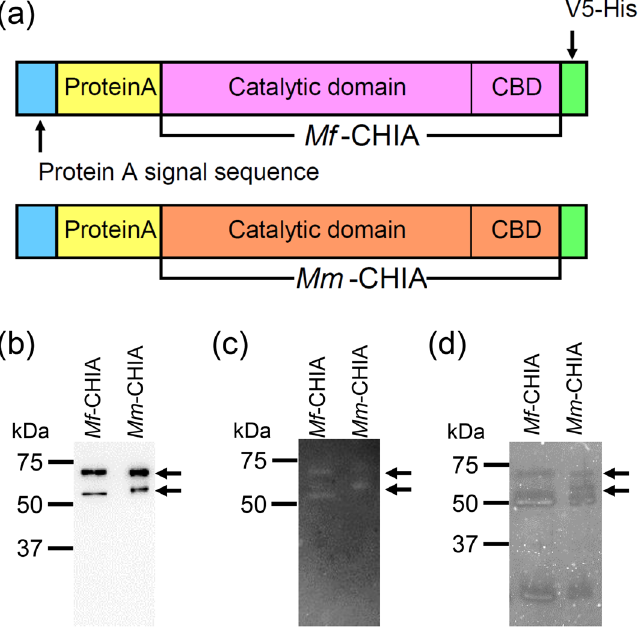
Figure 1. Schematic representations of the E. coli -expressed Mf -CHIA and Mm -CHIA fusion proteins (Protein A- Mf -CHIA or Mm -CHIA-V5-His). ( a ) E. coli -expressed Protein A- Mf -CHIA or Mm -CHIA-V5-His. The estimated size for Protein A- Mf -CHIA or Mm -CHIA-V5-His is 68 kDa. Analysis of the recombinant proteins by Western blot using the anti-V5 antibody ( b ). ( c ) Zymogram of Mf -CHIA and Mm -CHIA. ( d ) SYPRO Ruby stain. The images of ( b ), ( c ) and ( d ) were cropped from red dotted lines on original full-length gel images shown in Supplementary Fig. S2, S3, S4 and